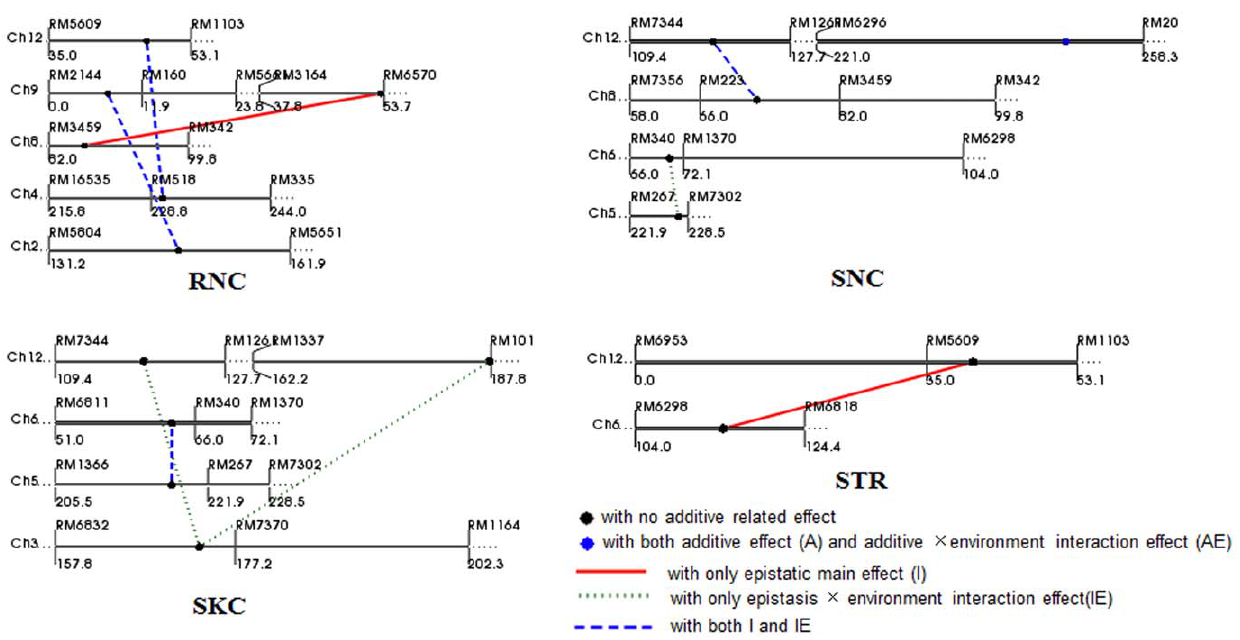
Figure 2. Location of additive and epistatic QTLs for salt tolerance indices with QTL 6 environment interactions on linkage groups by QTLNetwork.